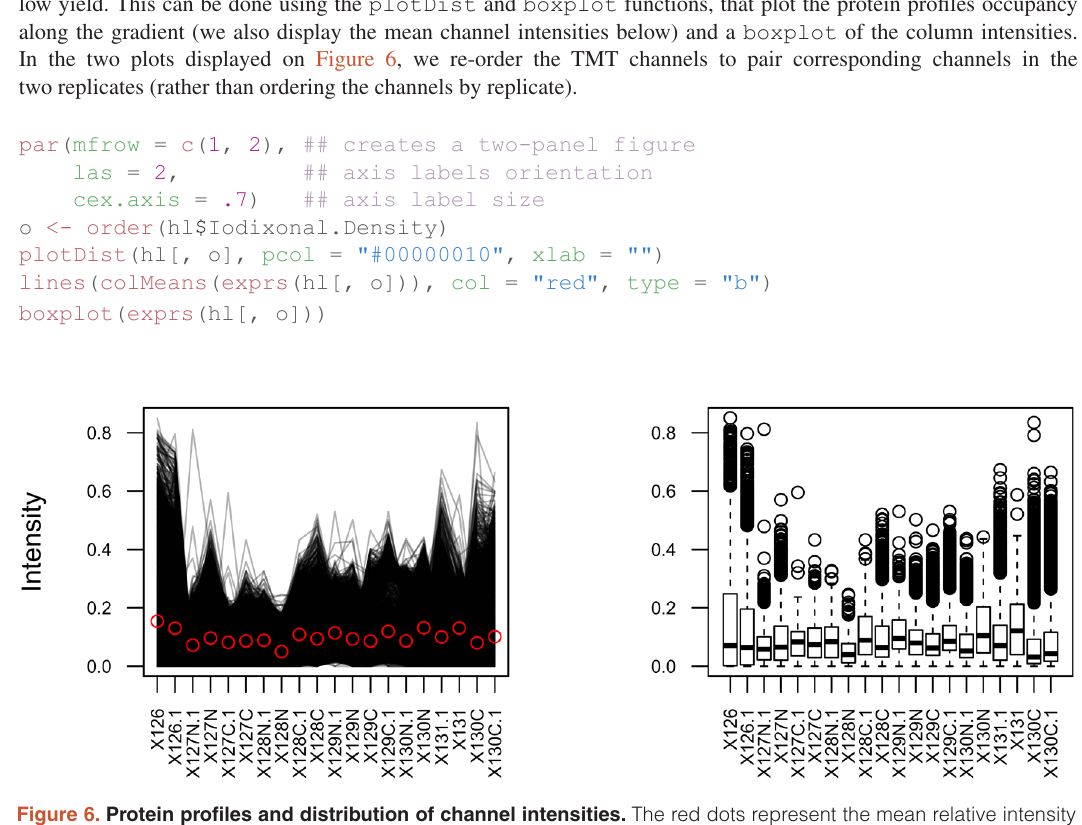
Figure 6. Protein profiles and distribution of channel intensities. The red dots represent the mean relative intensity for each channel.